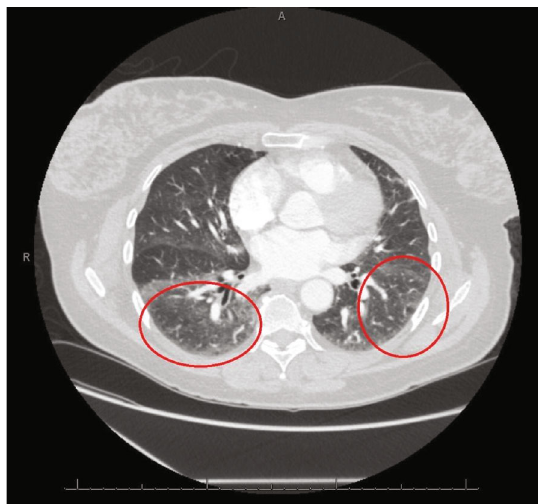
Figure 1: Our patient ’ s initial chest CT scan showing scattered ground glass opacities bilaterally (red circle).